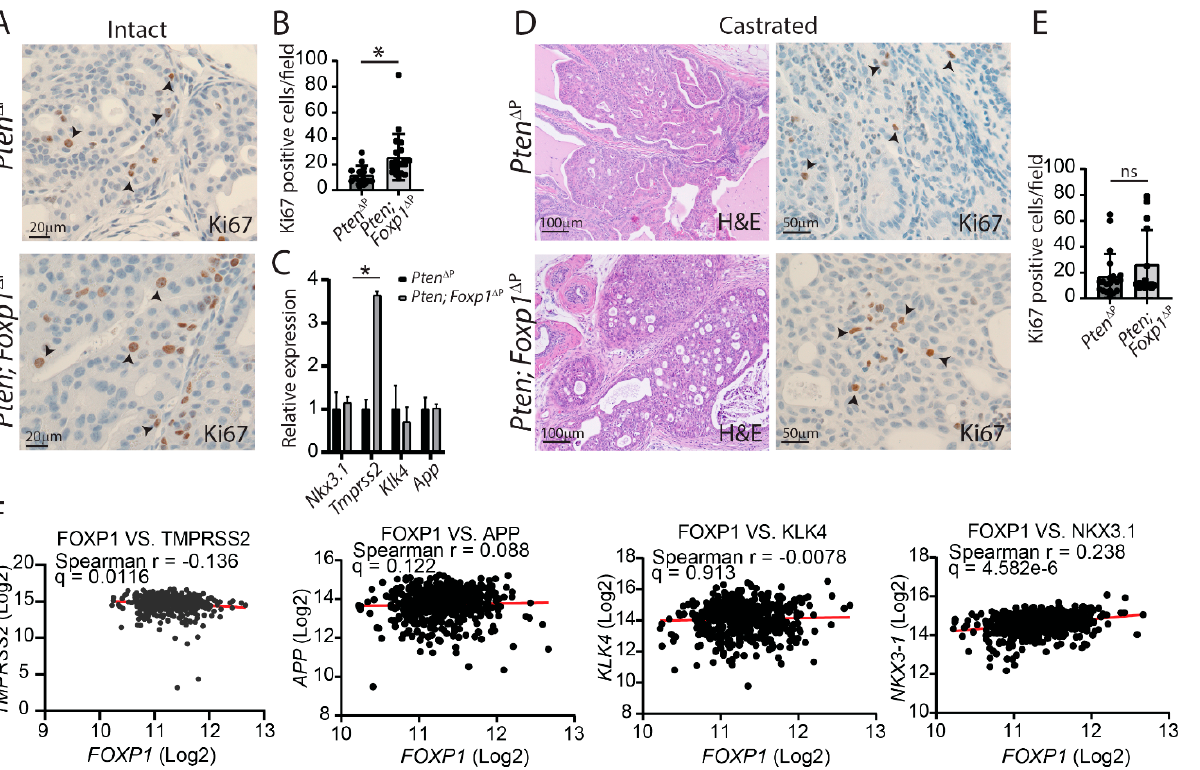
Figure 3. Loss of Foxp1 increases proliferation and expression of Tmprss2 in the prostate in an androgen manner. ( A ) Tissue sections from the anterior prostate lobes from Pten and Pten; Foxp1 deficient samples were stained for Ki67 ( n = 5). ( B ) Quantification of Ki67-positive cells was assessed from a total of 25 fields from five mice (* = p < 0.05). ( C ) Expressions of AR-regulated genes were measured from Pten and Pten ; Foxp1 -deficient samples ( n = 4, * = p < 0.05). ( D ) Mice deficient in Pten or Pten; Foxp1 in the prostatic tissues underwent castration one month before samples were collected. Tissue sections were stained with H & E and Ki67. Black arrowheads mark positive cells (brown stain) ( n = 5). ( E ) Ki67-positive cells were quantified from both genotypes from a total of 15 fields (ns = non-significant). ( F ) The correlation between FOXP1 and AR-regulated genes was assessed from the TCGA Pan Cancer data set containing 494 samples.